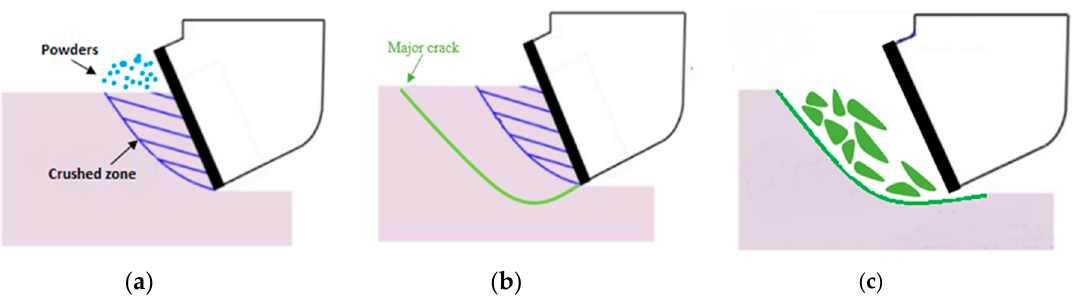
Figure 7. The schematic picture of cutter and cuttings during the scratching rock sample: ( a ) the cutting type is a powder; ( b ) major cracks are formed; ( c ) the chips are formed in front of the cutter.